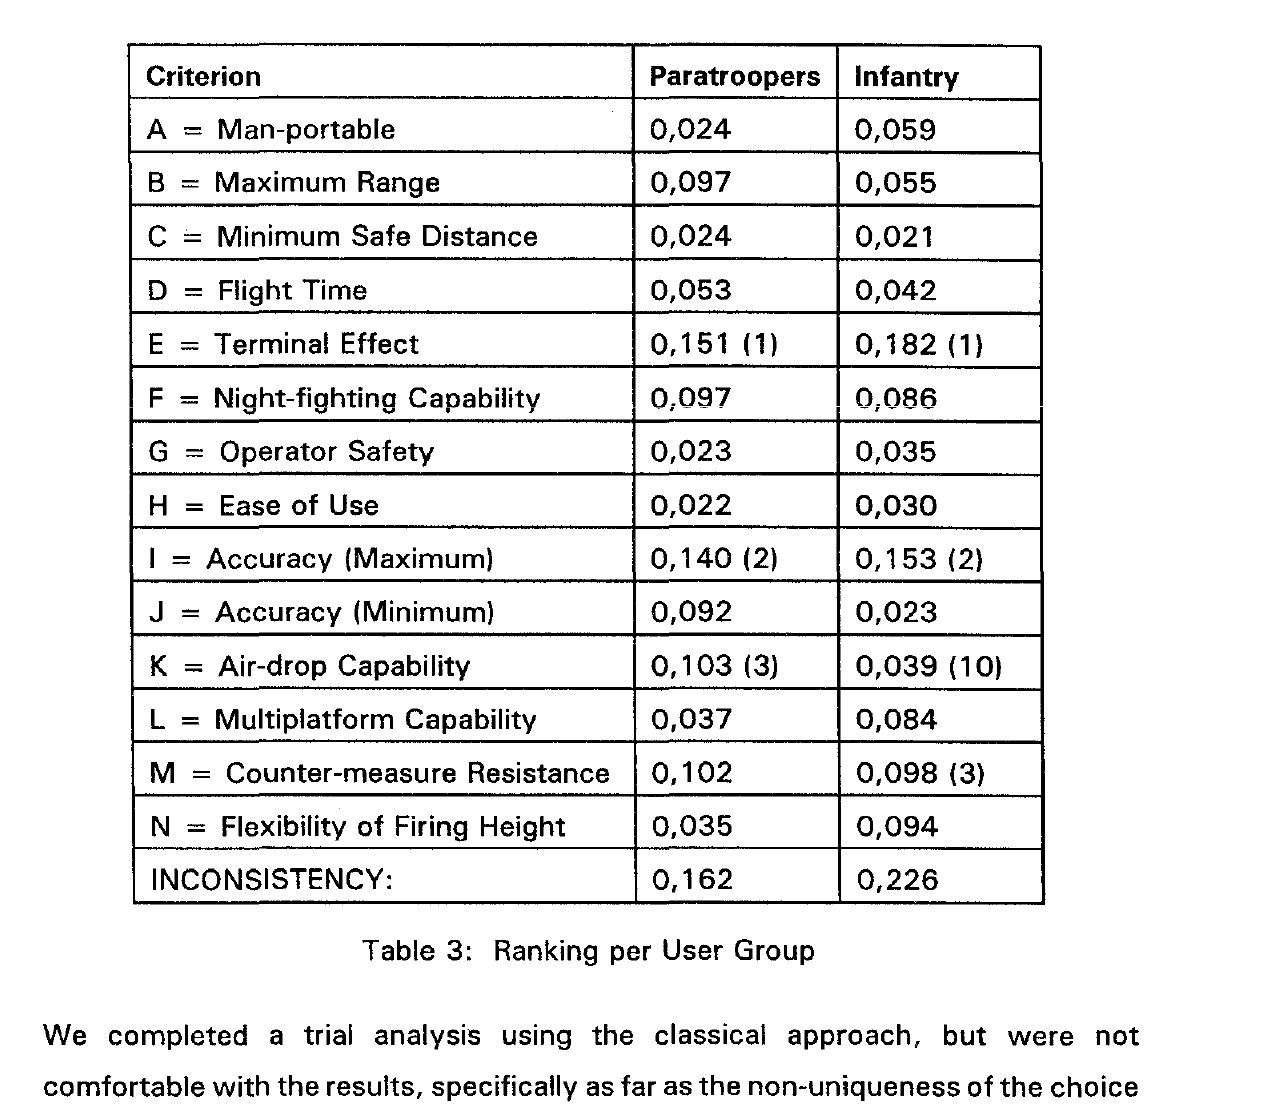
Table 3: Ranking per User